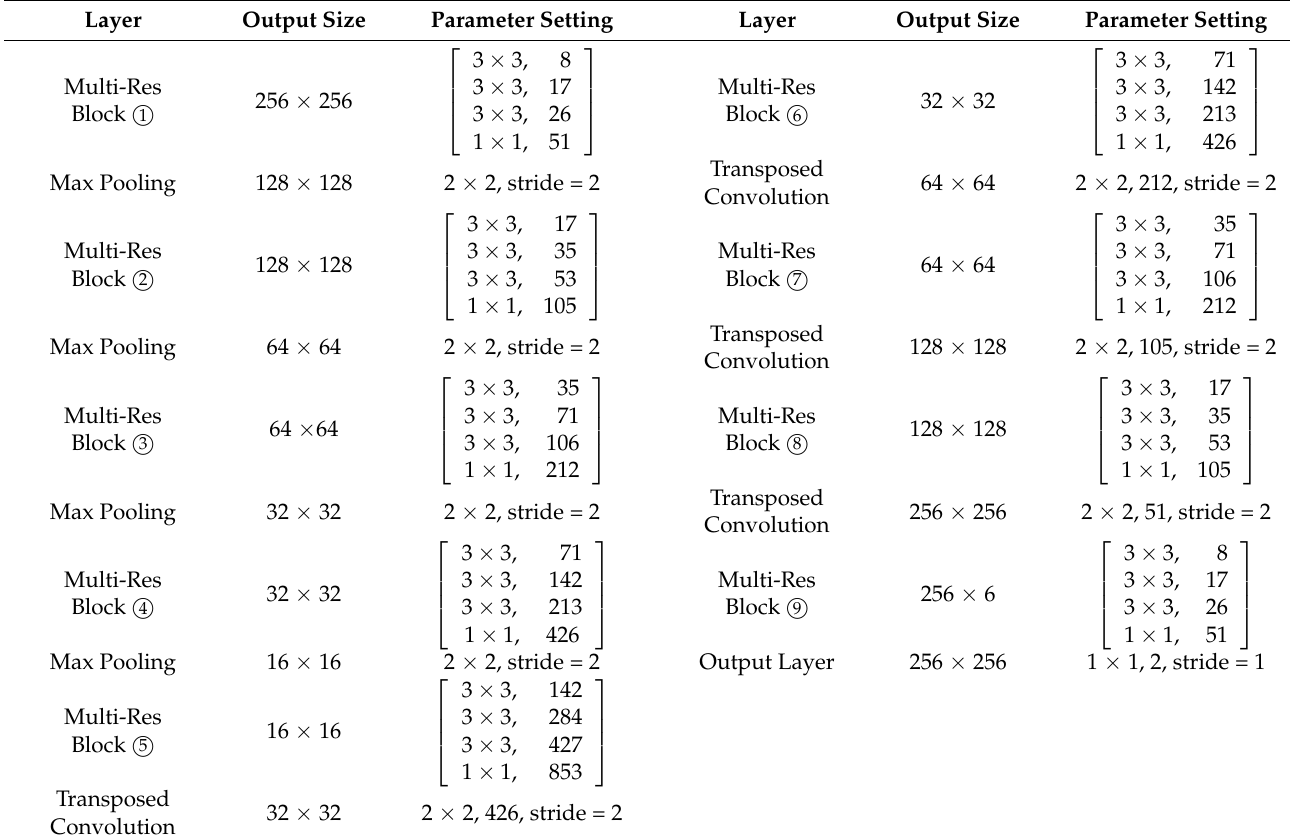
Table 1. The details of MRA-SNet architecture. The symbols 1 (cid:13) to 9 (cid:13) indicate the corresponding Multi-Res block number in Figure 1.